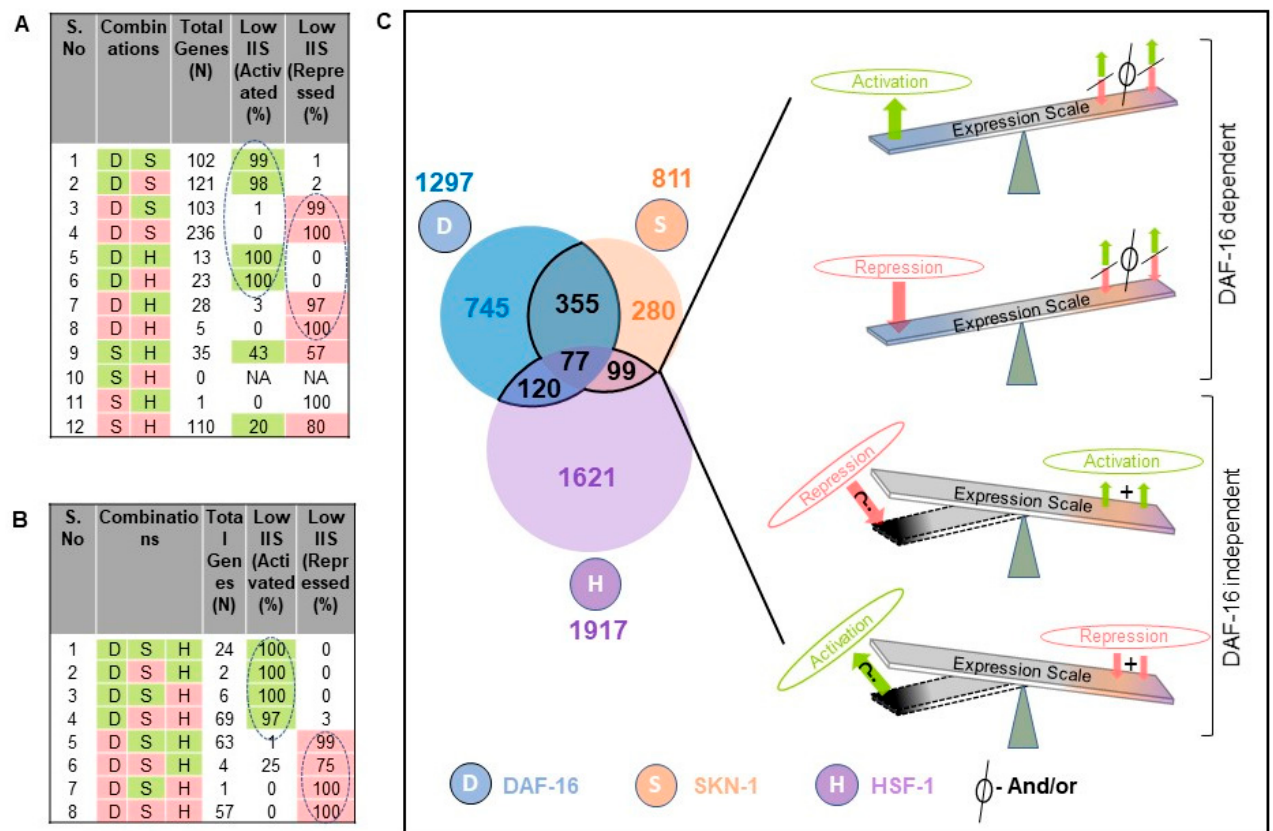
Figure 5. DAF-16 is a key determining factor for the combinatorial regulation of genes. ( A ) Genes are shared by any two TFs. Serial No. 1–8: Differential expression of most genes under rIIS condition (last two columns) are the same as controlled by DAF-16 (first column). Serial No. 9–12: DAF-16-independent genes jointly regulated by SKN-1 and HSF-1. Several genes (57% and 20 %) expressed under the rIIS condition were found to be opposite to the SKN-1 and HSF-1 nature of regulation. ( B ) Genes shared by all three TFs. It shows the dominant nature of DAF-16 under the rIIS condition to determine the direction of expression of the commonly regulated gene by all three TFs. Green and red color boxes indicate activated and repressed genes, respectively. Dotted oval shaped circles represent most of the genes either activated or repressed jointly by any two ( A ) or all three TFs ( B ) under rIIS condition. ( C ) Model for common genes targeted by any two or all three TFs. The relative contribution of TFs is incorporated to provide a nuanced portrayal of the multiple possibilities that cause the expression of gene targets under the rIIS condition. In this view, the effect of TFs on the right side is shown with a seesaw. In the above two panels, overweighted seesaw side indicates DAF-16 dominance irrespective of the contribution made by the other two TFs under the rIIS condition. However, the majority of DAF-16-independent genes are either activated or repressed by SKN-1 or HSF-1 synergistically, but few others behave differently, as indicated by the overweighted dark color side. The result is that wherever DAF-16 is involved, it masks the effect of other